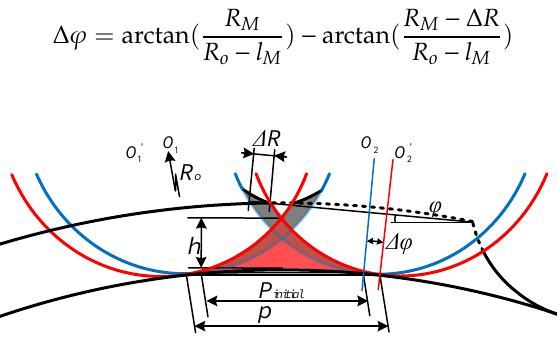
Figure 5. Diagram of the relationship between wear and residual height.